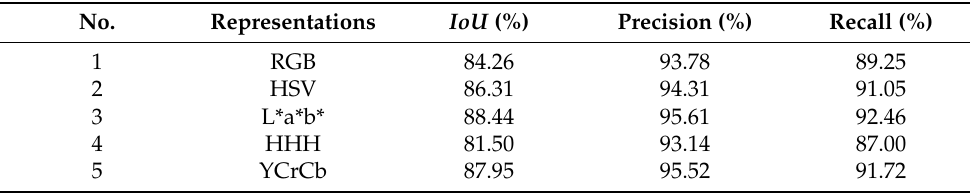
Table 5. Performance of different input